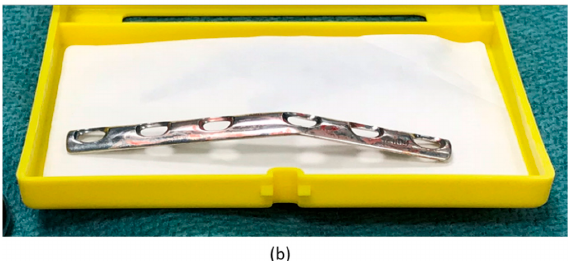
Figure 6. ( a ) The bone allograft was cut according to the preoperative simulation; ( b ) a one-third tubular 3.5 mm locking compression plate was shaped according to the preoperative simulation.